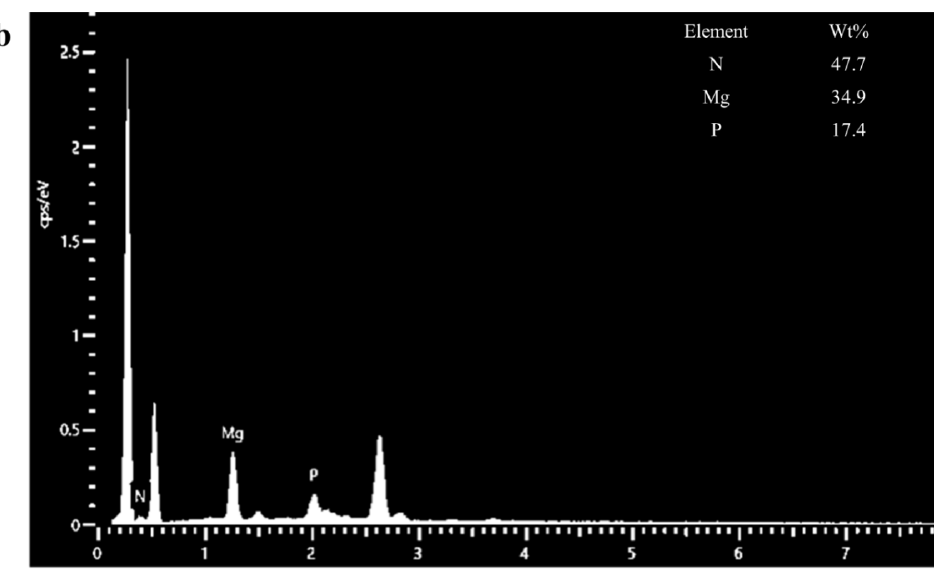
Figure 6. EDS spectra of struvite crystals formed from synthetic urines ( a ) before and ( b ) after the photocatalytic process (using 1% Sr-doped TiO 2 photocatalyst).